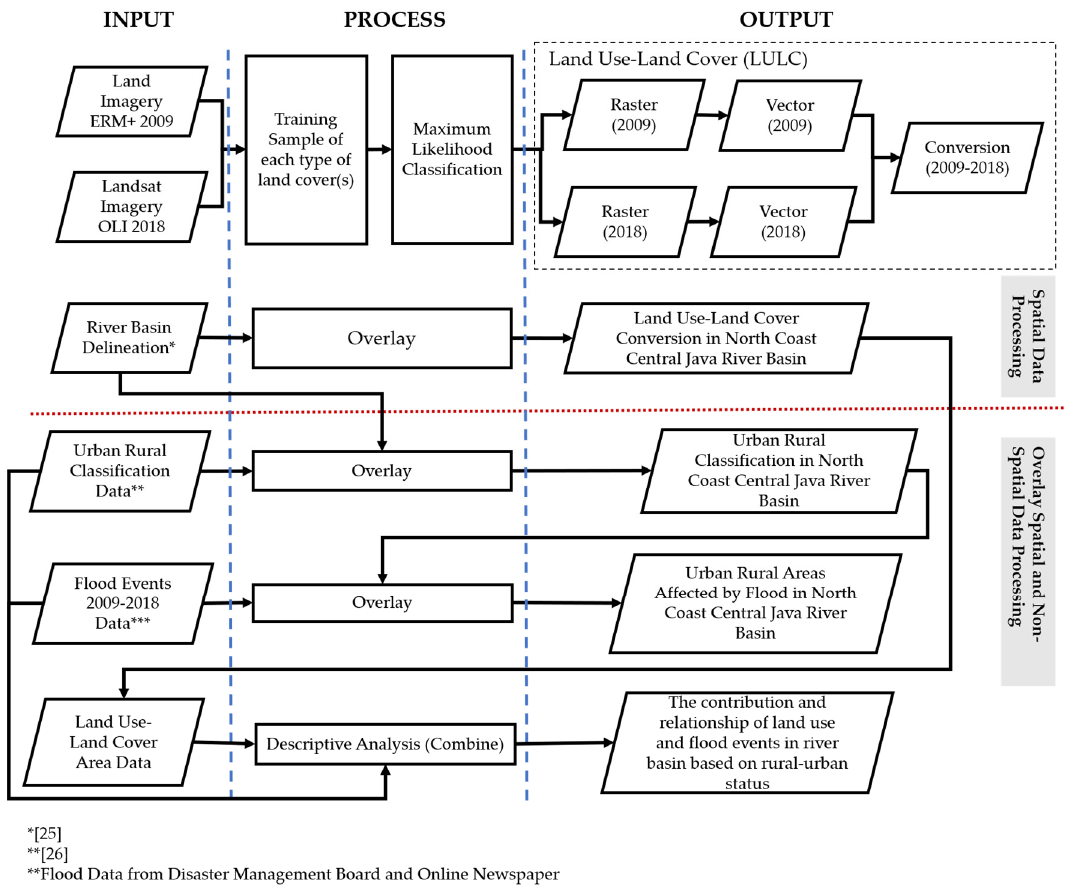
Figure 3. Analytical Method Flowchart.